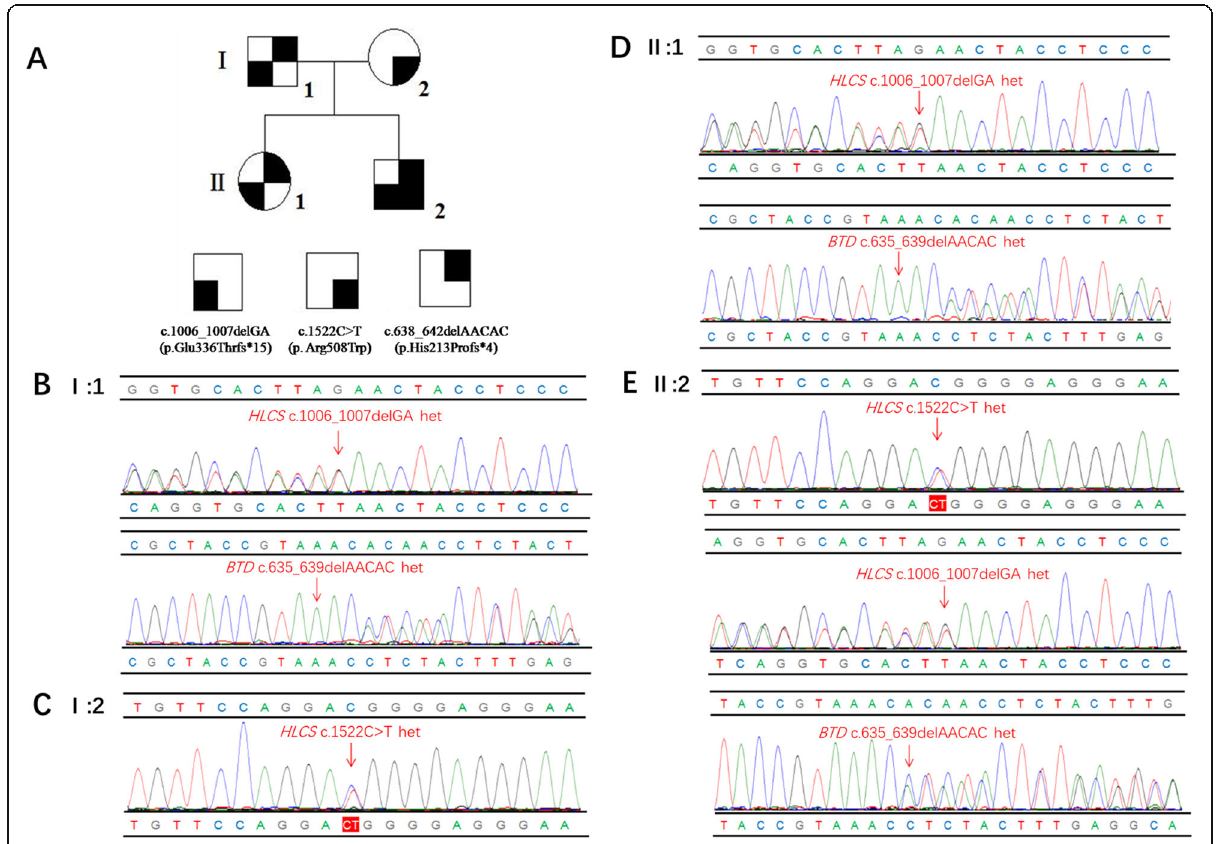
Fig. 1 a Pedigree of the family. The black arrow denotes the proband. b - e Validation of the HLCS and BTD gene mutations by Sanger sequencing. Heterozygous mutations c.1522C> T, c.1006_1007delGA and c.638_642delAACAC were identified in the proband ( ǁ :2),